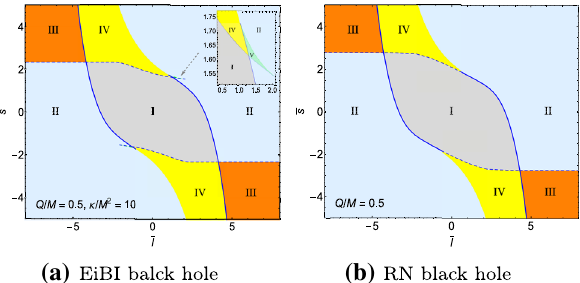
Fig. 6 Thepropertiesofthecircularorbitsforthespinningtestparticle in EiBI black hole and RN black hole. The gray colored region I refers to the parameters without stable circular orbit. The light blue colored regions II refers to the parameters with only one stable timelike circular orbits. The yellow colored regions IV refer to the parameters with only spacelike and unphysical circular orbits. The orange colored region III and green colored region V refer to the parameters with two stable circular orbits